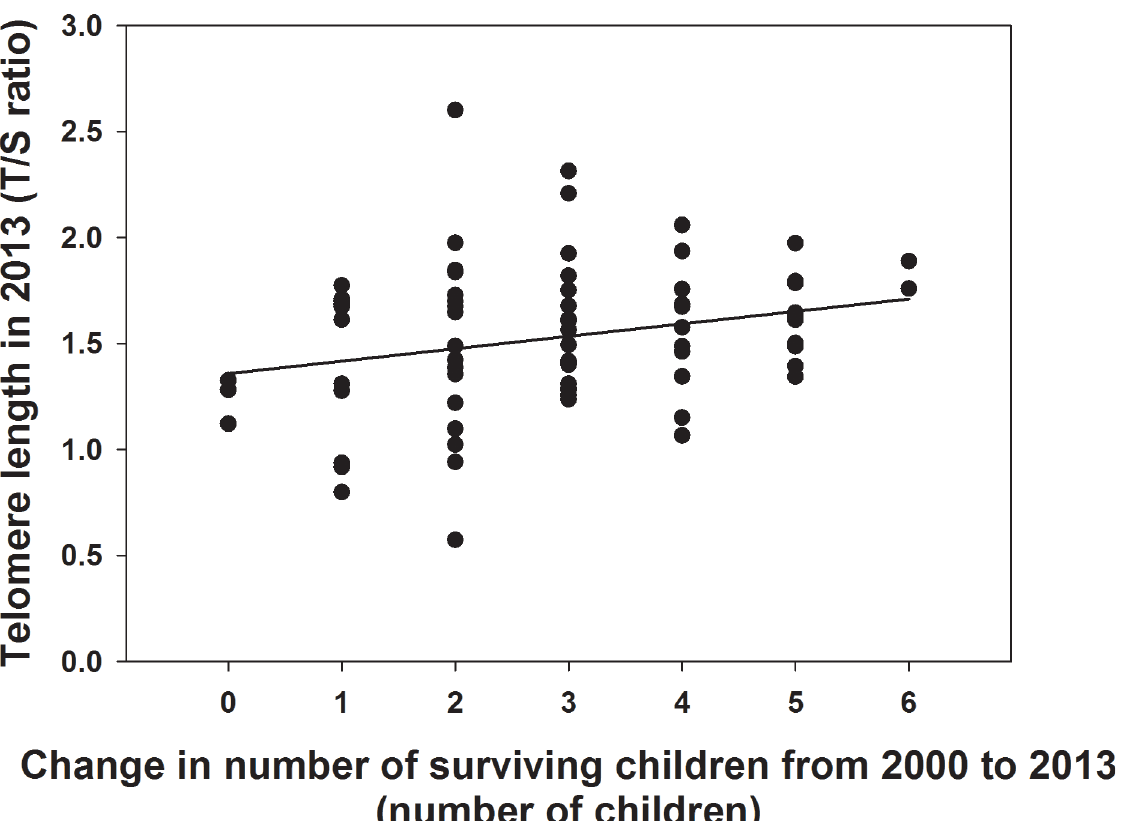
Fig 1. Change in number of surviving children and telomere length. Women who had more children from 2000 to 2013 had longer telomere lengths in 2013 than women who had fewer children, after controlling for their telomere length in 2000 and age in